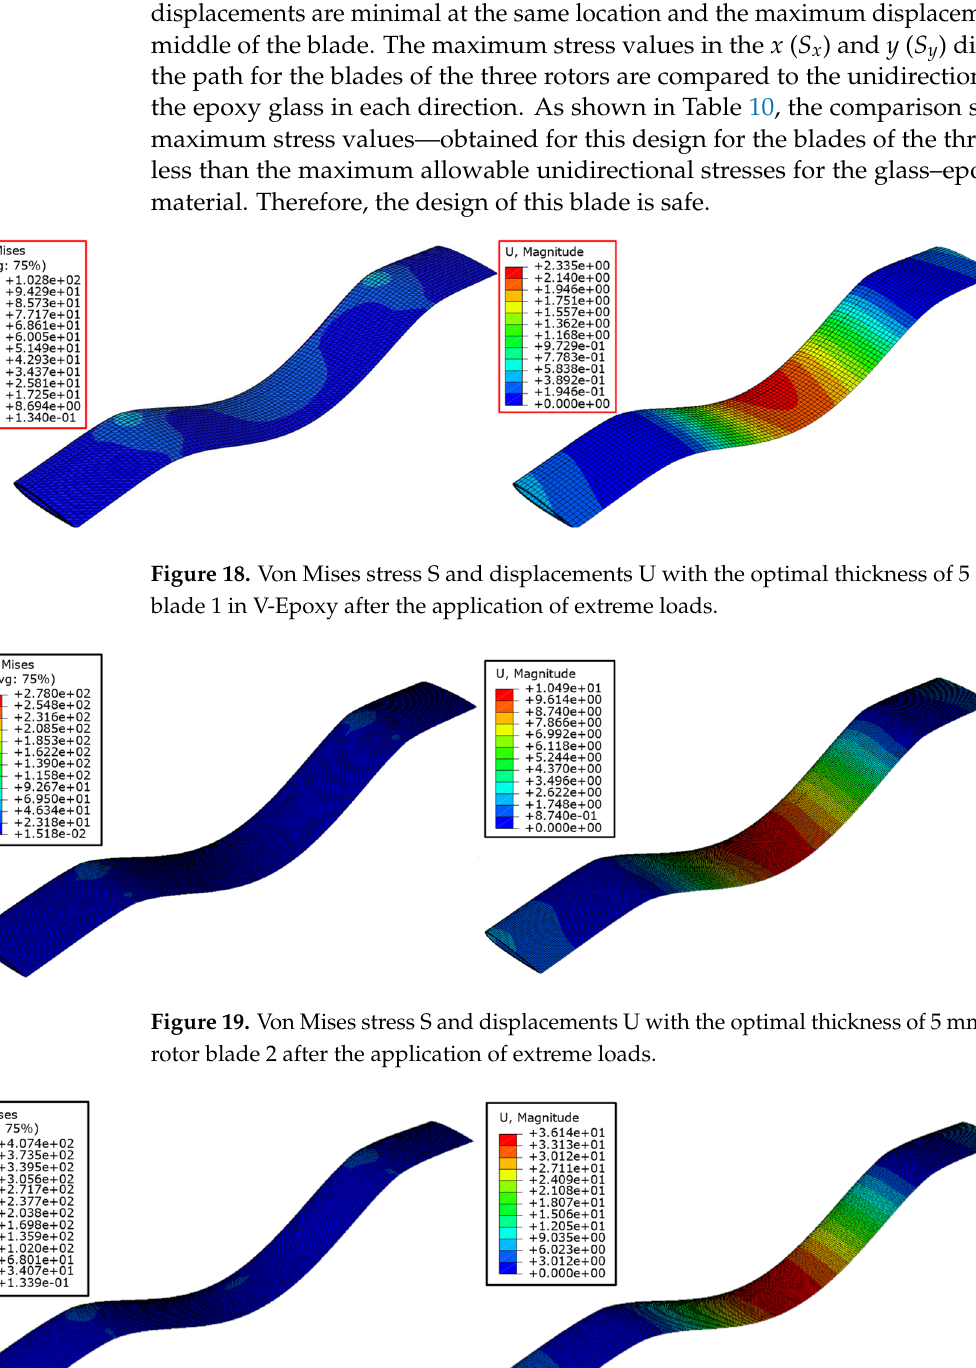
Table 9. Optimal thicknesses of the glass–epoxy plies with their orientation.